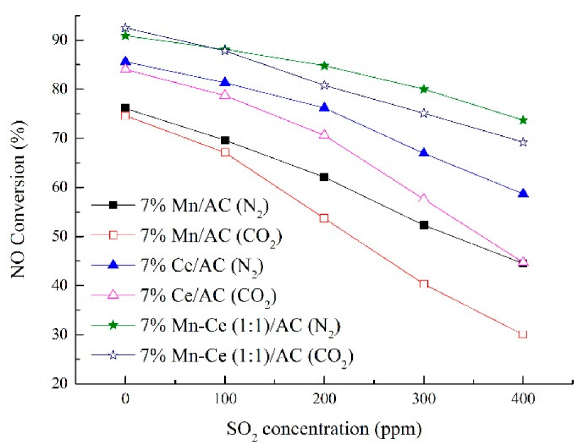
Figure 8. NH 3 -SCR using different SO 2 concentrations under CO 2 and N 2 atmosphere. Other conditions: temperature 250 °C; 800 ppm NO; 800 ppm NH 3 ; 6% O 2 and space velocity 3408 h − 1 .